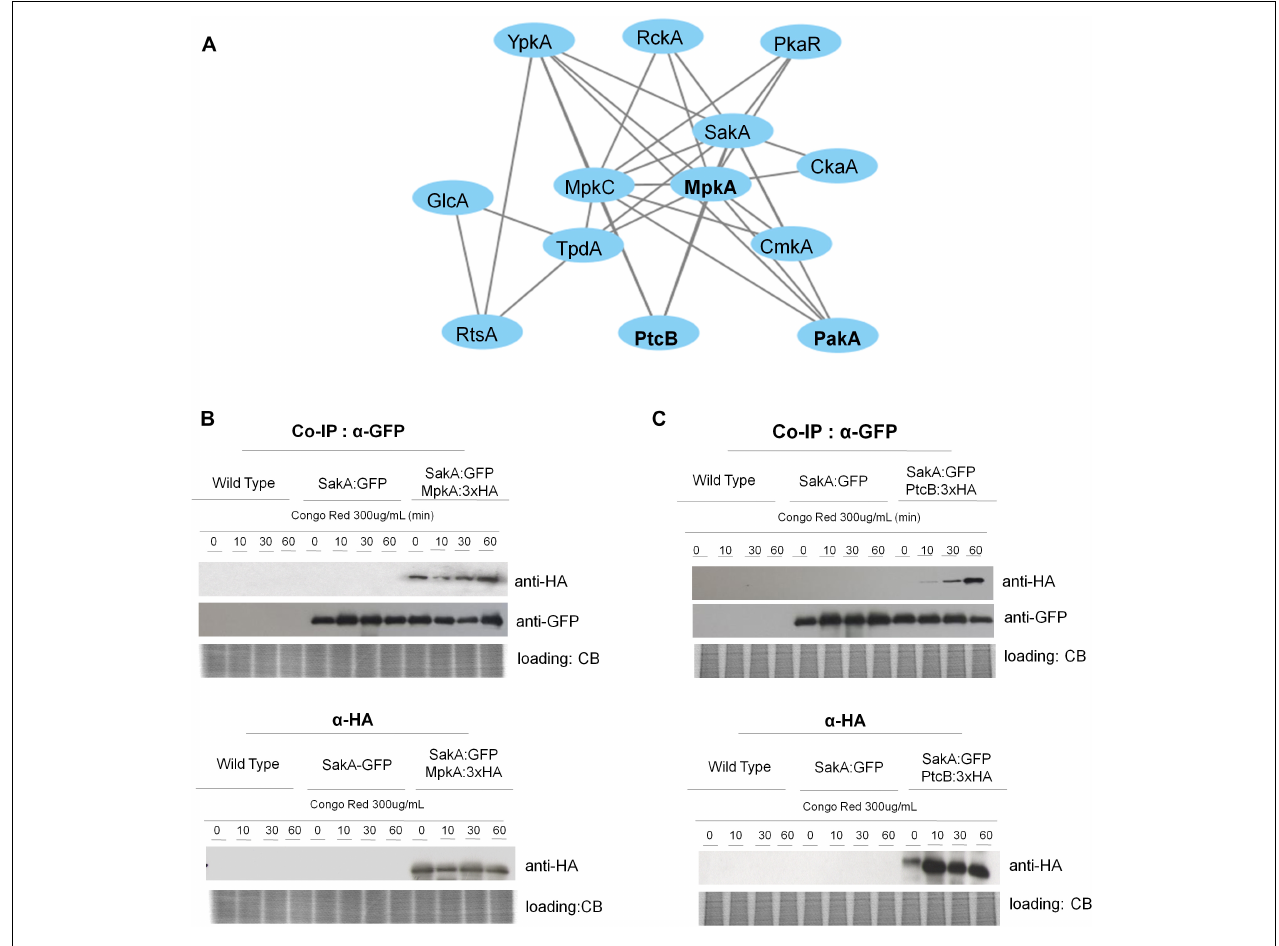
FIGURE 3 | SakA:GFP associates with MpkA and PtcB. (A) Interaction network performed by using STRING (https://string-db.org/) showing the interaction among SakA, MpkC, MpkA, PtcB, and PakA. (B) Co-IP of SakA:GFP, MpkA:3xHA, SakA:GFP, and PtcB:3xHA. Affinity purification assays from GFP-tagged SakA strain